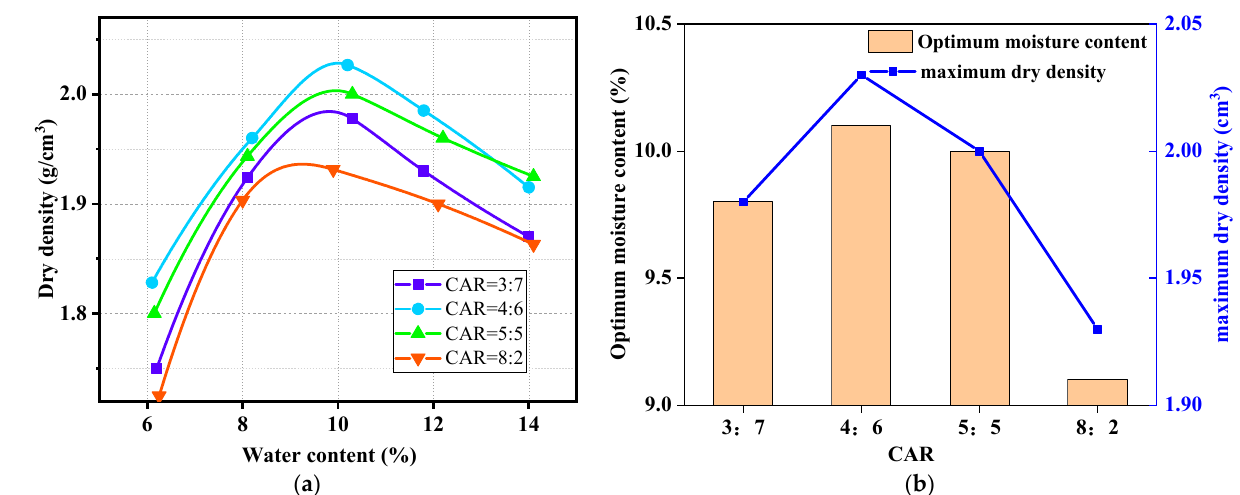
Figure 5. ( a ) Relationship curve between moisture content and dry density; ( b ) optimum moisture content and maximum dry density corresponding to different CARs.